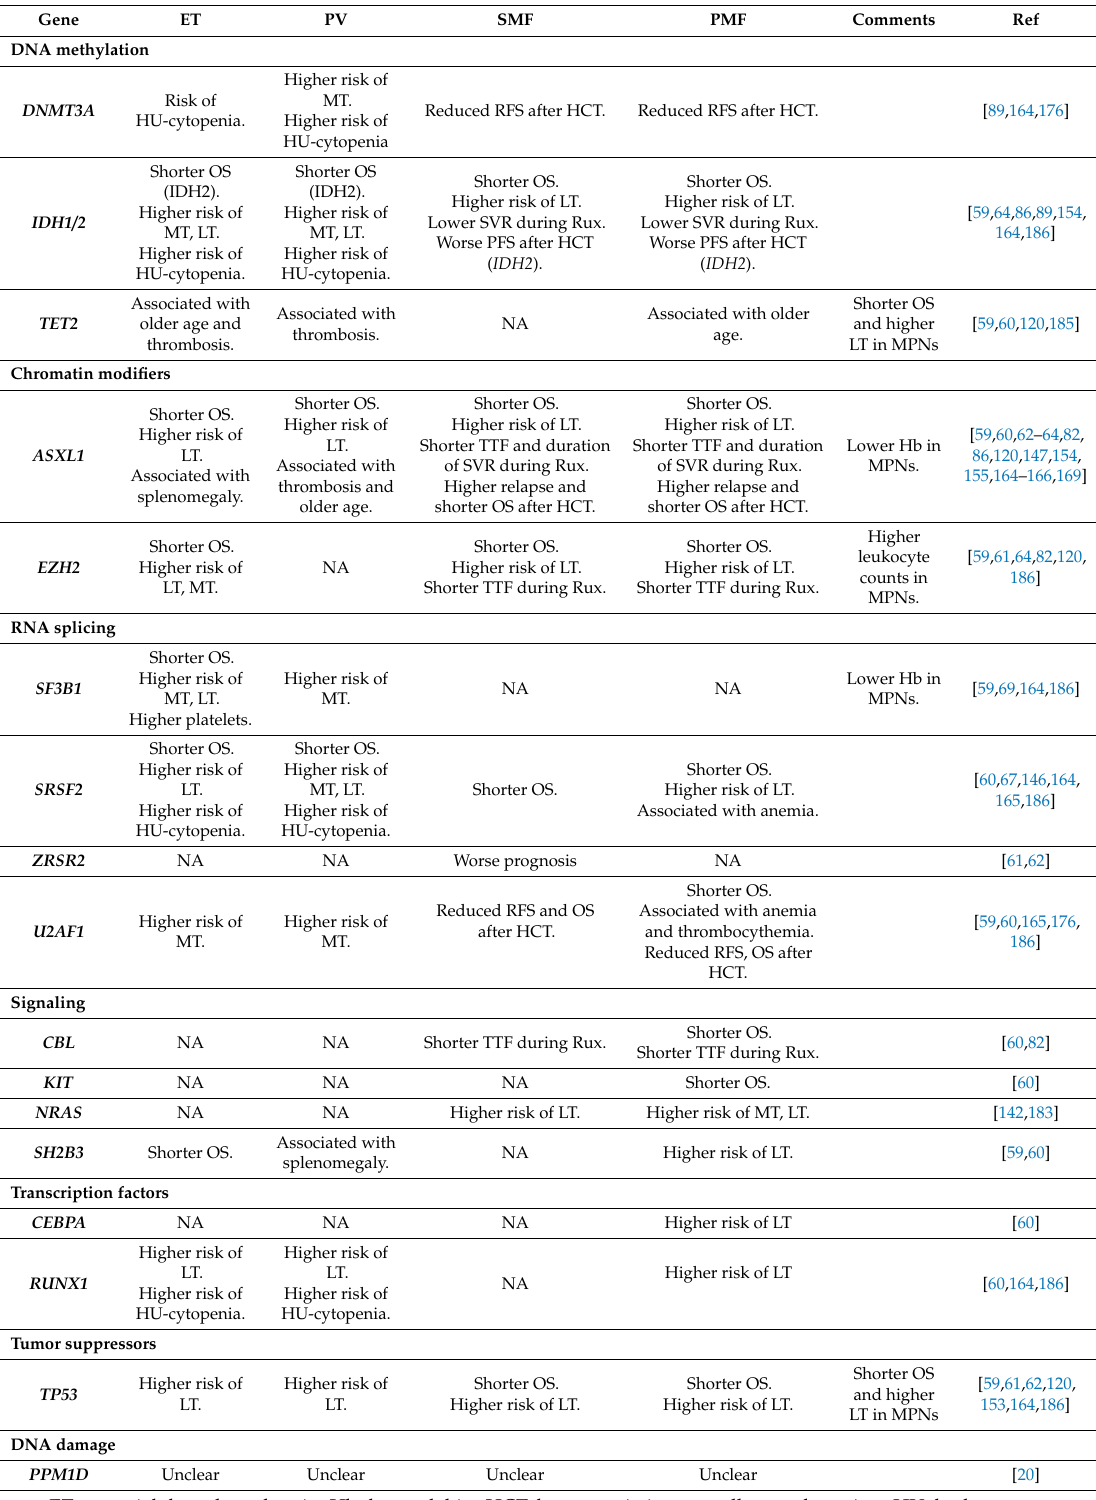
Table 3. The clinical significance of the most common additional gene mutations in MPNs elaborated by NGS studies.